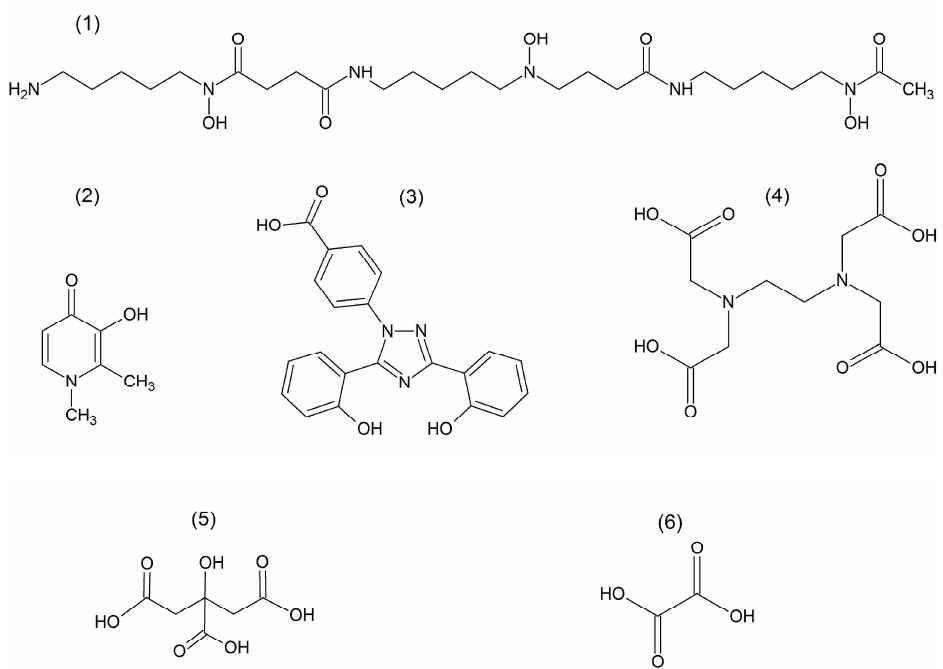
Figure 2. The chemical structures of the iron chelating drugs deferoxamine (1), deferiprone (2), deferasirox (3), ethylenediaminetetracetic acid (EDTA) (4), and the naturally occurring chelators citric acid (5) and oxalic acid (6).